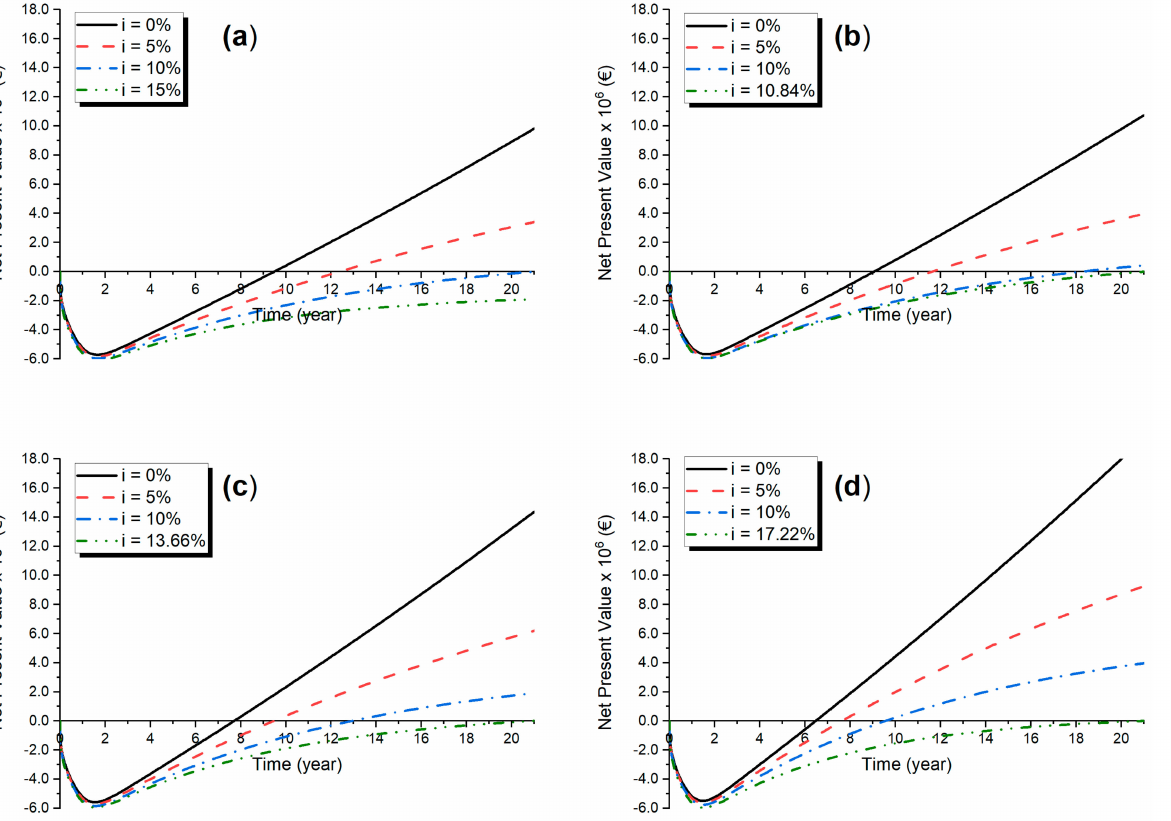
Figure 3. Cumulative cash flow diagrams at different discount rates for ( a ) 0.66, ( b ) 0.67, ( c ) 0.72, and ( d ) 0.79 € /Nm 3 CH 4 selling prices,